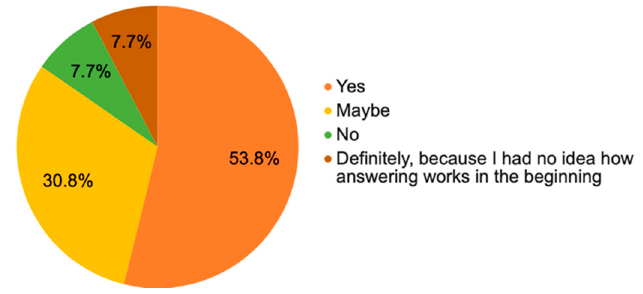
Figure 2. The importance of a user manual or a video tutorial.